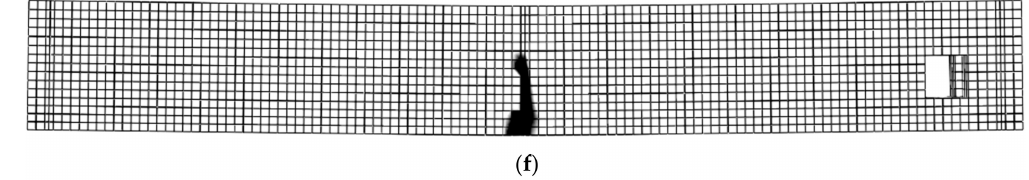
Figure 12. Failure modes of some beams listed in groups 10–14: ( a ) Beam B4; ( b ) B10-2 (Tension); ( c ) B11-2 (Tension); ( d ) B12-2 (Tension); ( e ) B13-2 (Tension); ( f ) B14-2